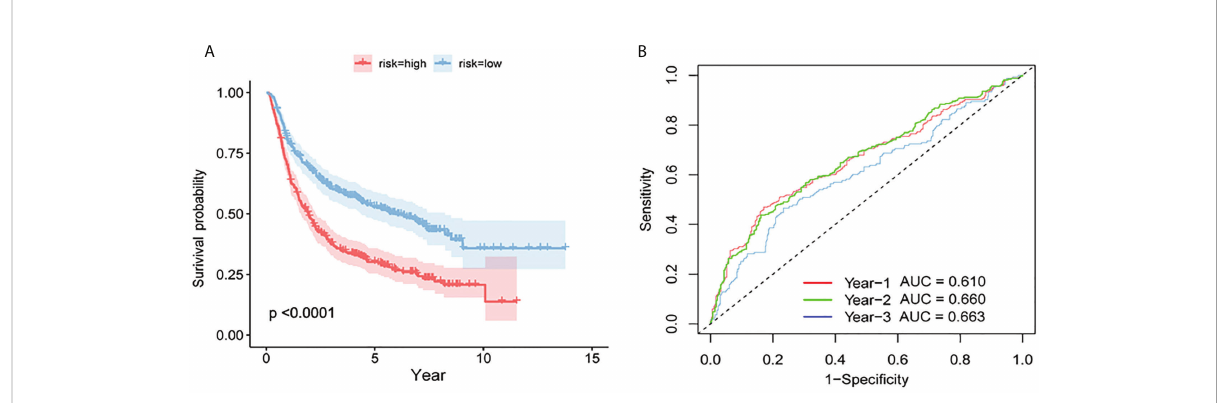
FIGURE 7 Veri fi cation of the prognostic model by CGGA. (A) Survival curves for high- and low-risk groups in the CGGA test set. (B) Test set based on time-dependent ROC curve for prognosis based on the risk score.